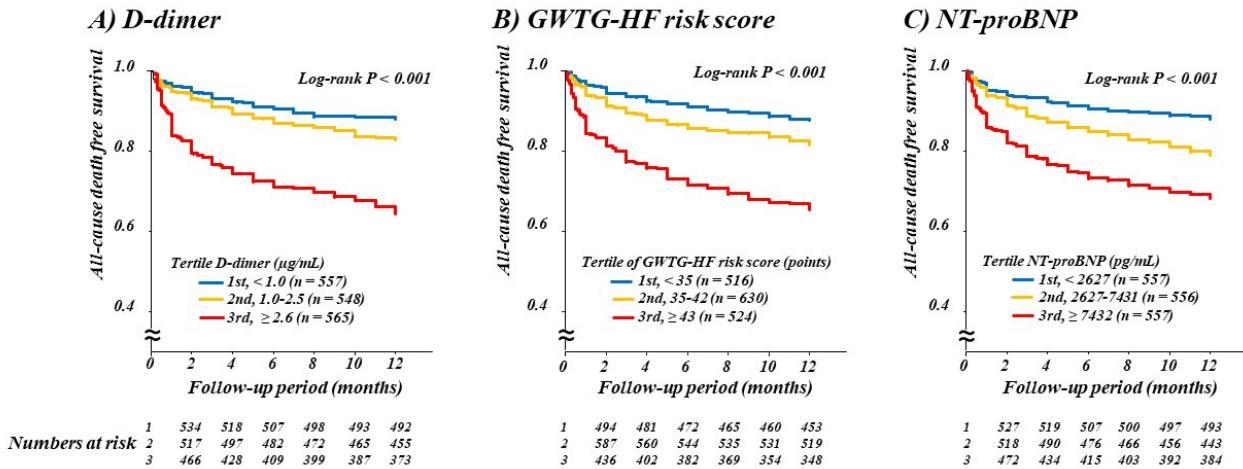
Figure 1. Kaplan-Meier curves for all-cause mortality according to tertiles of D-dimer, GWTG-HF risk score, and NT-proBNP. Numbers at risk in the respective groups are shown below the plots. GWTG-HF, Get With The Guidelines—Heart Failure; NT-proBNP, N-terminal pro-B-type natriuretic peptide. ( A ) D-dimer; ( B ) GWTG-HF risk score; ( C ) NT- proBNP.